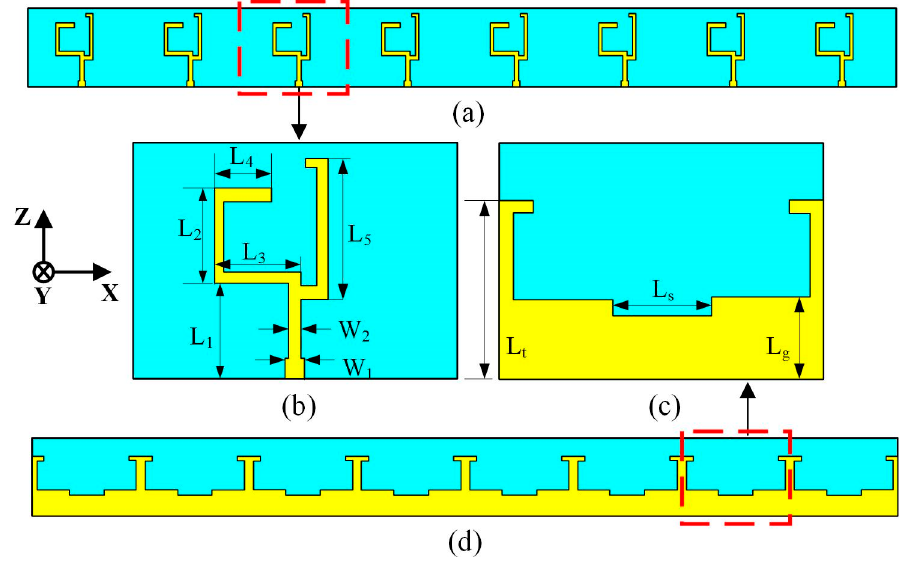
Figure 3. ( a ) Front view of the eight-element MIMO antenna; ( b ) front view of the single-element antenna; ( c ) bottom view of the single-element antenna; ( d ) bottom view of the proposed eight-element MIMO antenna.